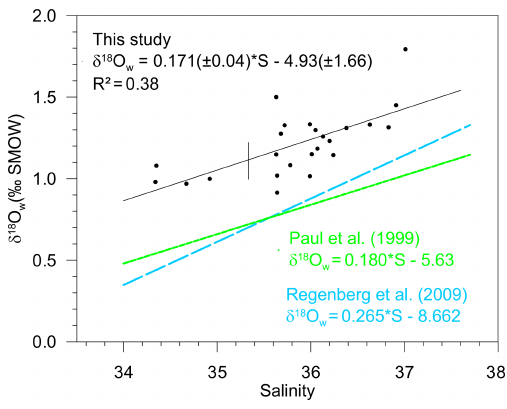
Figure 5. Measured surface δ 18 O w (‰ SMOW) plotted versus measured surface salinity (stations listed in Table 4) (black dots and full line). Regression lines of the δ 18 O w –salinity relationship cal- culated by Paul et al. (1999) for the tropical Atlantic Ocean (from 25 ◦ S to 25 ◦ N), based on GEOSECS data (green line), and by Re- genberg et al. (2009) (dashed blue line), based on Schmidt (1999) data for the Atlantic Ocean for the water depth interval of